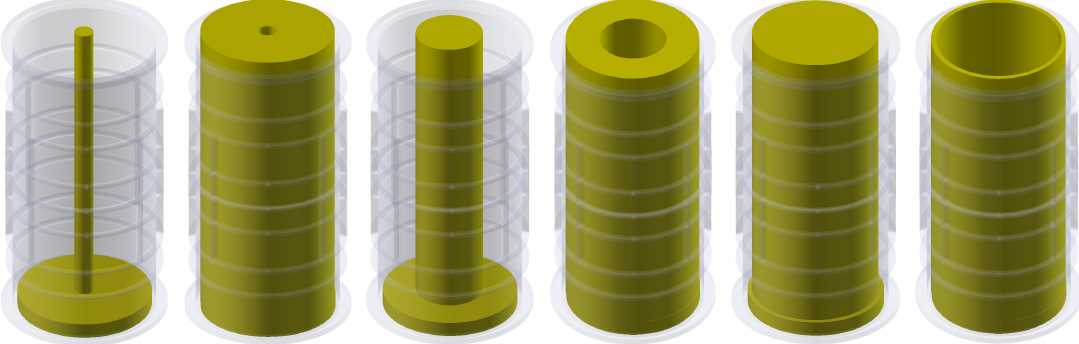
Figure 6. Arrangement of tested low-contrast objects according to Table 1—from the leftmost Test A , Test B , Test C